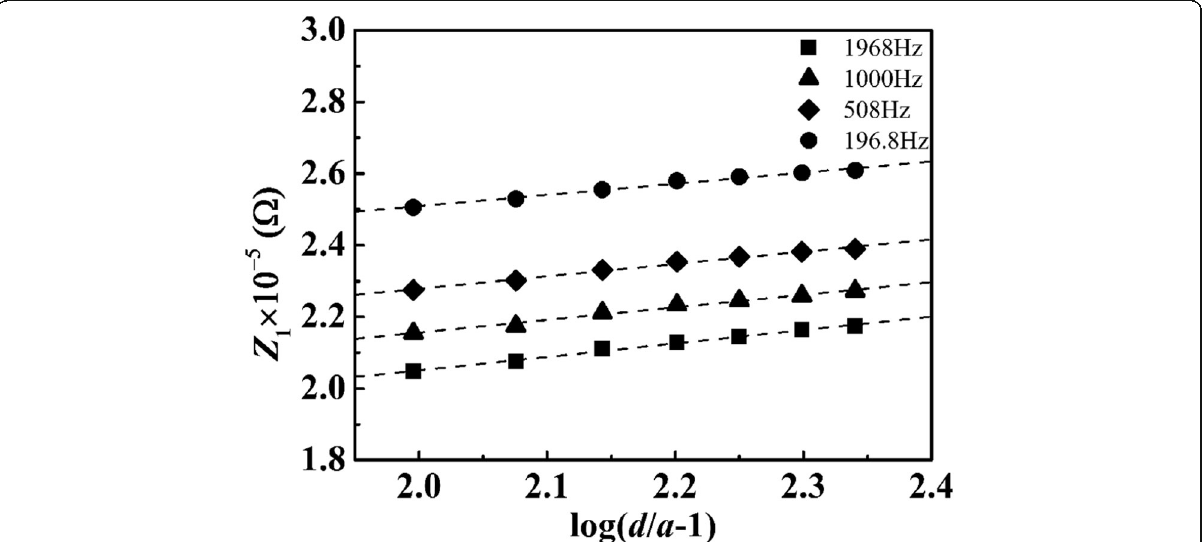
Fig. 3 Plot of the real part of the AC impedance of a typical PSA suspension against log( d / a − 1) for frequencies f = 196.8, 508, 1000, and 1968 Hz,